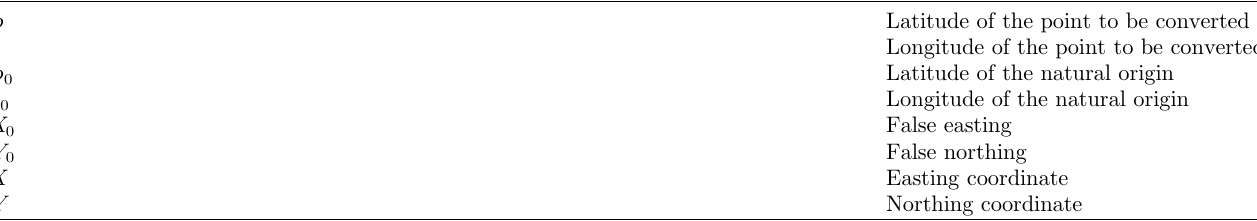
Table C-1. De fi nitions and symbols of